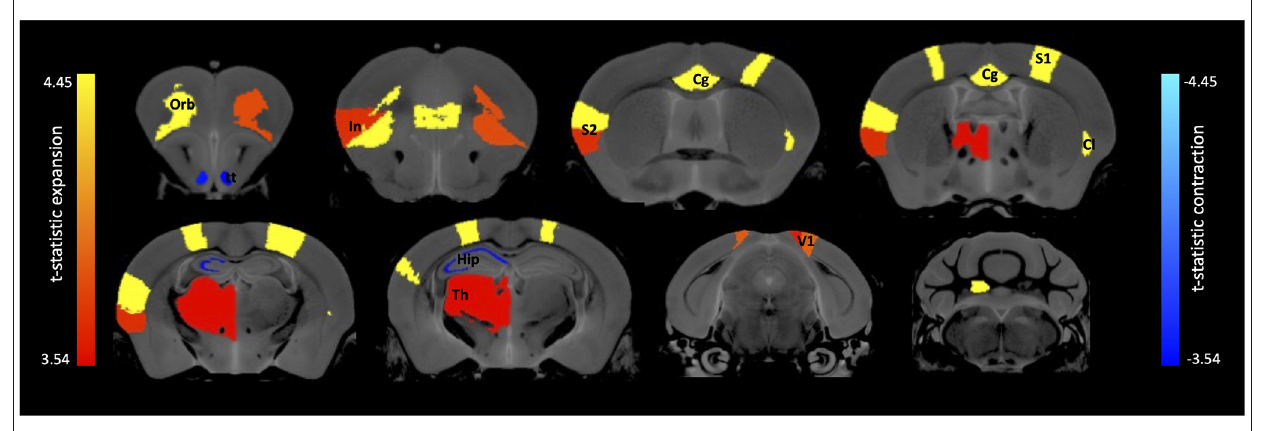
FIGURE2 Brain regions showing volume expansion and contraction following 7,8-DHF administration. Anatomical labels: Cg, cingulate cortex; Cl, claustrum; Hip, hippocampus; In, insular cortex; Orb, orbital cortex; S1, primary somatosensory; S2, secondary somatosensory; Th, thalamus; tt, tenia tecta; V1, primary visual.